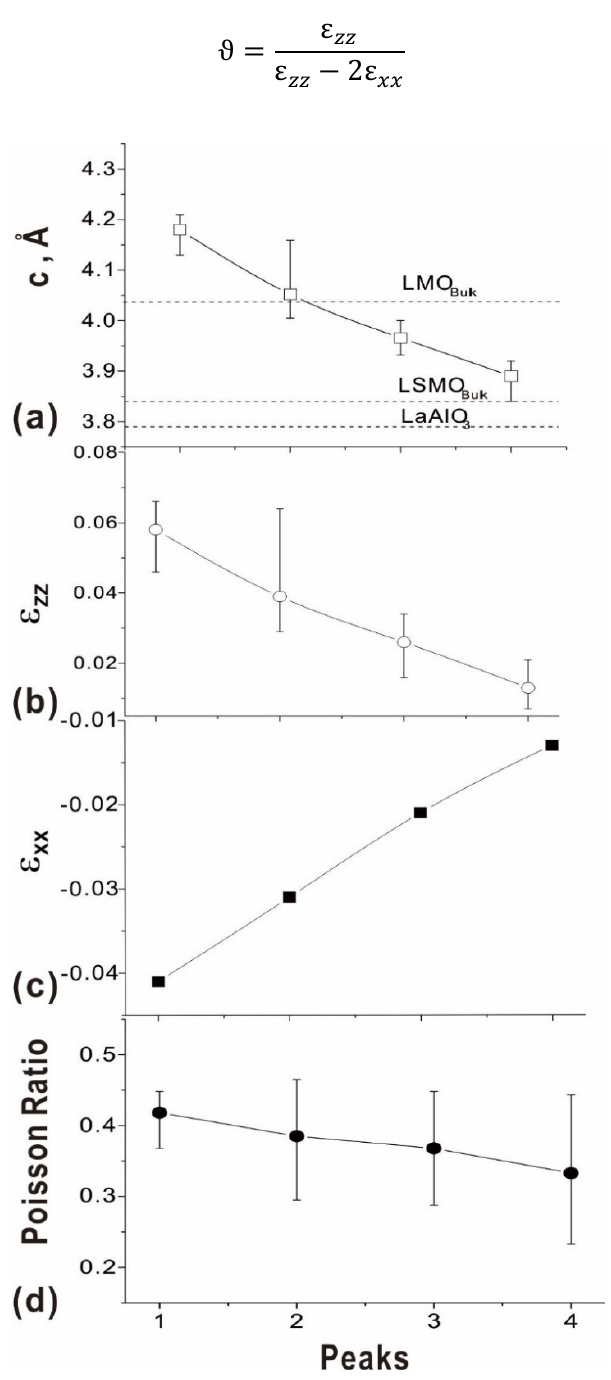
Figure 9. Variation of ( a ) c lattice parameter, ( b ) the corresponding out-of-plane strain, ( c ) in-plane strain and ( d ) Poisson’s ratio calculated from low angle XRD